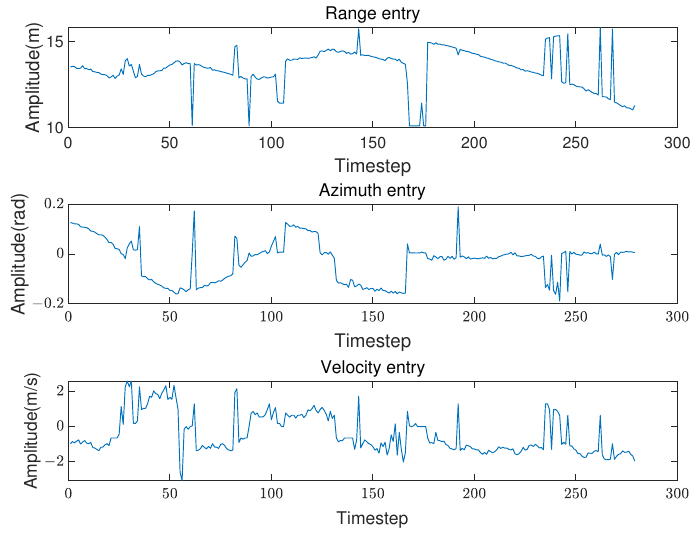
Figure 13. Raw data plots in three-dimensional entries in the measurement vector.